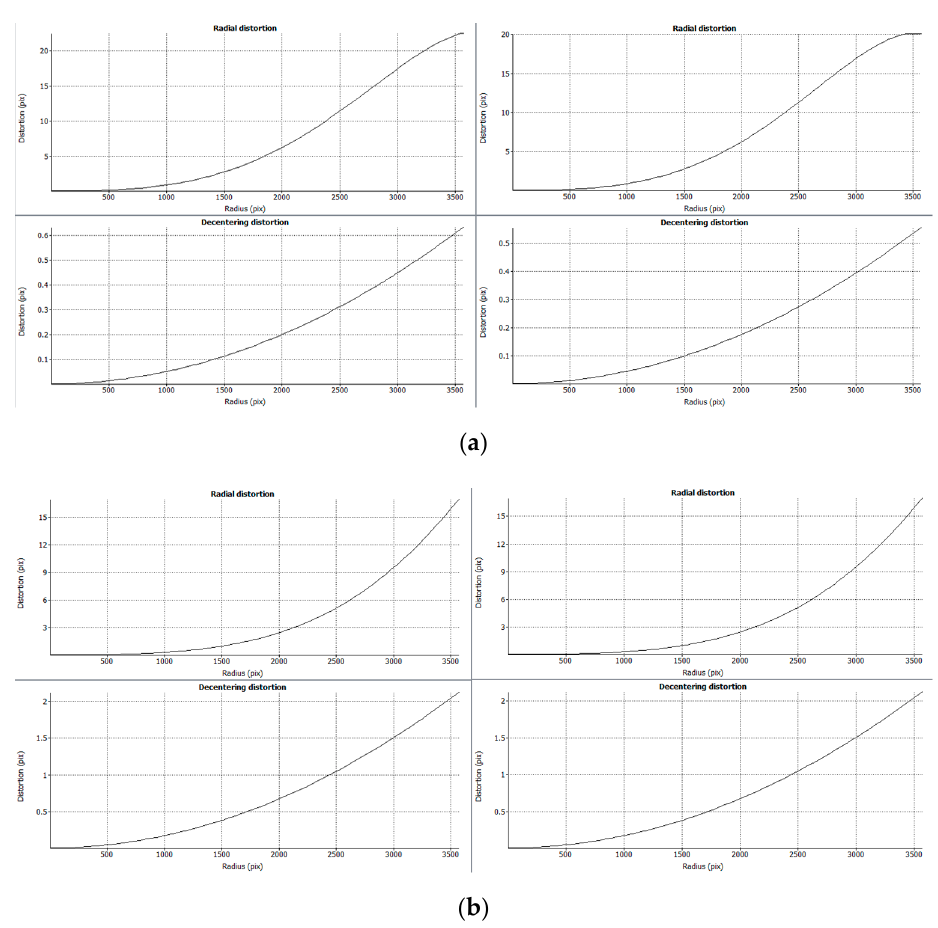
Figure 6. Examples of calibration curves for the specimen 1 (separator): ( a ) zoom lens pre-calibrated (left) and self-calibrated (right); ( b ) macro lens pre-calibrated (left) and self-calibrated (right).